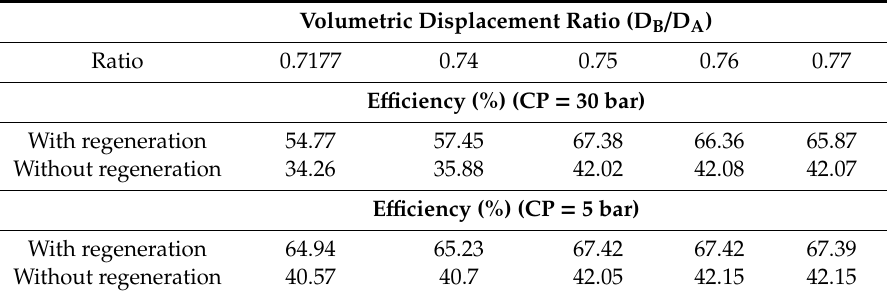
Table 3. Overall e ffi ciency related to the volumetric displacement Table 3. Overall efficiency related to the volumetric displacement ratios.